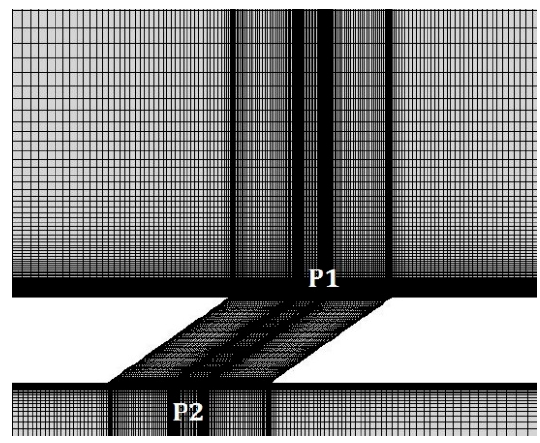
Figure 6. The CFD (Computational fluid dynamics) mesh reproducing the Seo et al. [7] case.